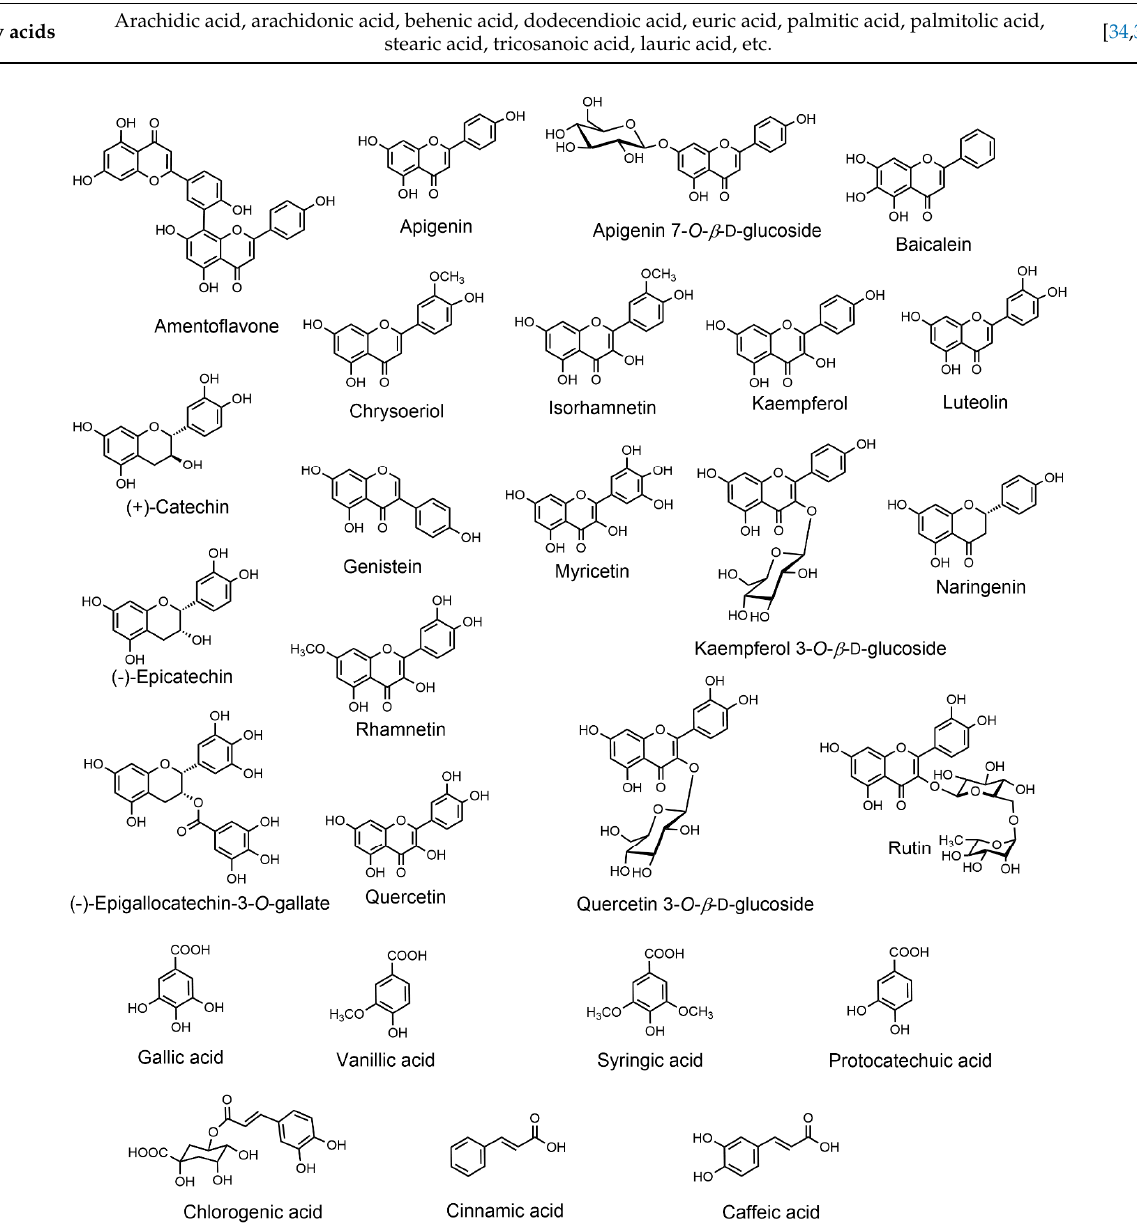
Figure 2. Structures of major flavonoids and phenolic acids reported from the leaves of Urtica dioica. Table 1. Bioactive chemical constituents of leaves of Urtica dioica.